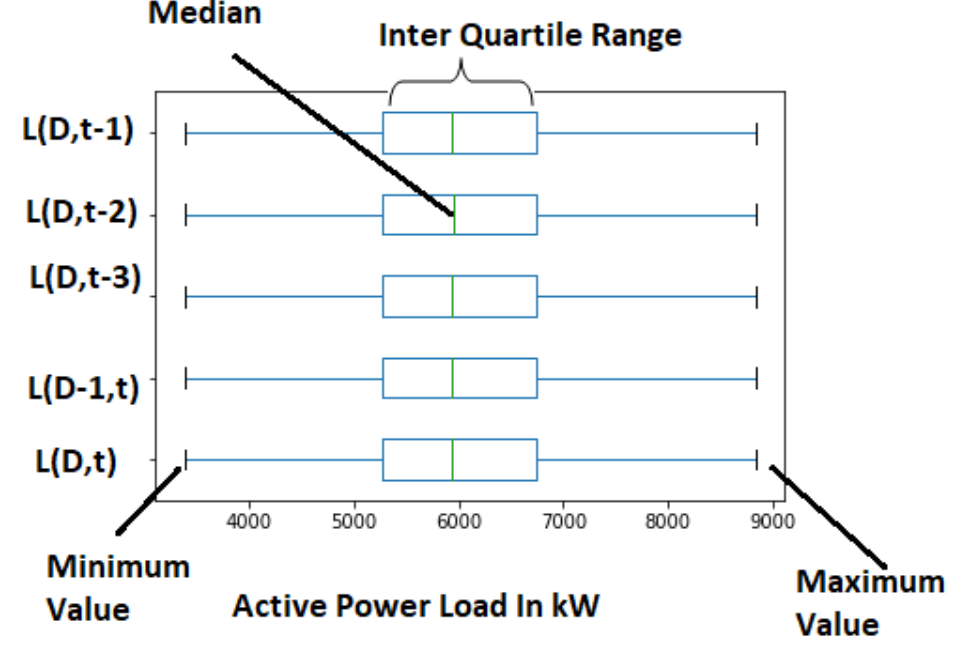
Figure 16. MLR: Data observation using box plot.